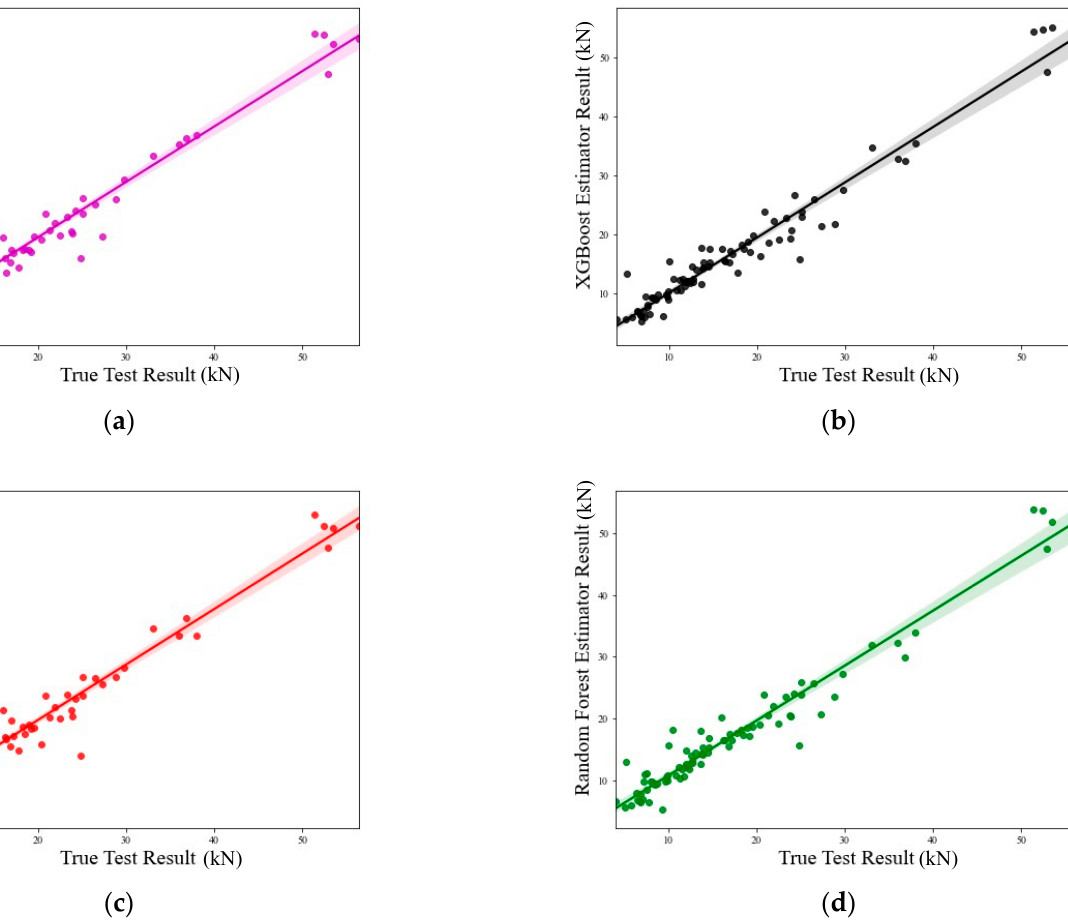
Figure 6. Estimator result analysis of the ensemble methods: ( a ) CatBoost, ( b ) XGBoost, ( c ) HGBoost, and ( d ) random forest.